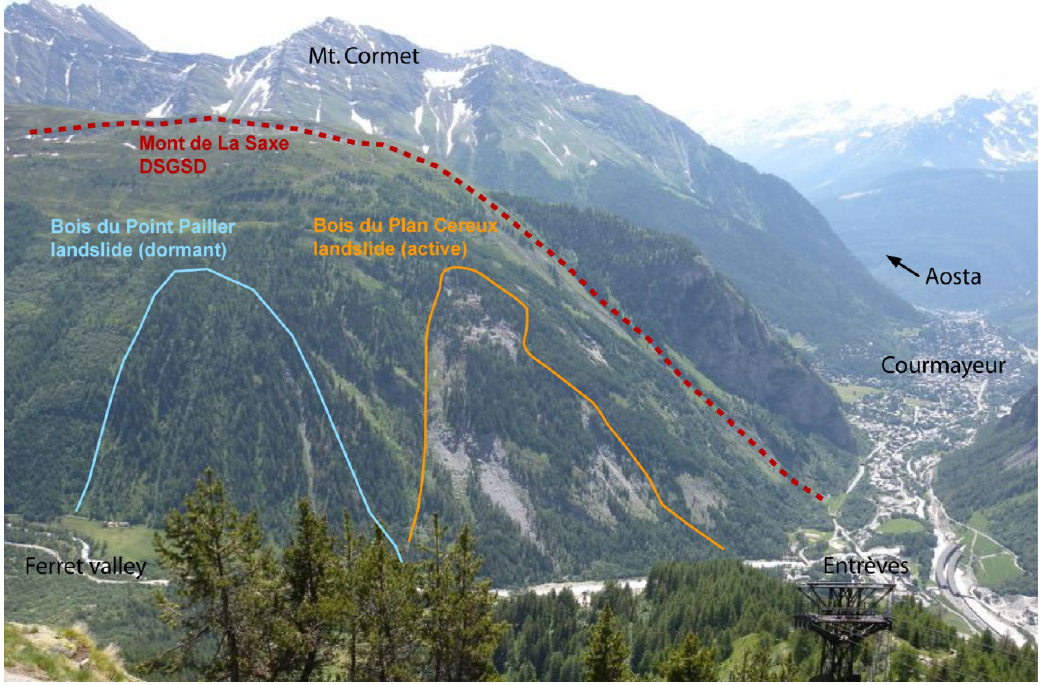
Figure 3. Frontal view of the Mont de la Saxe deep-seated gravitational slope deformation (DSGSD) showing the Bois du Plan Cereux active landslide and the Bois du Point Pailler dormant